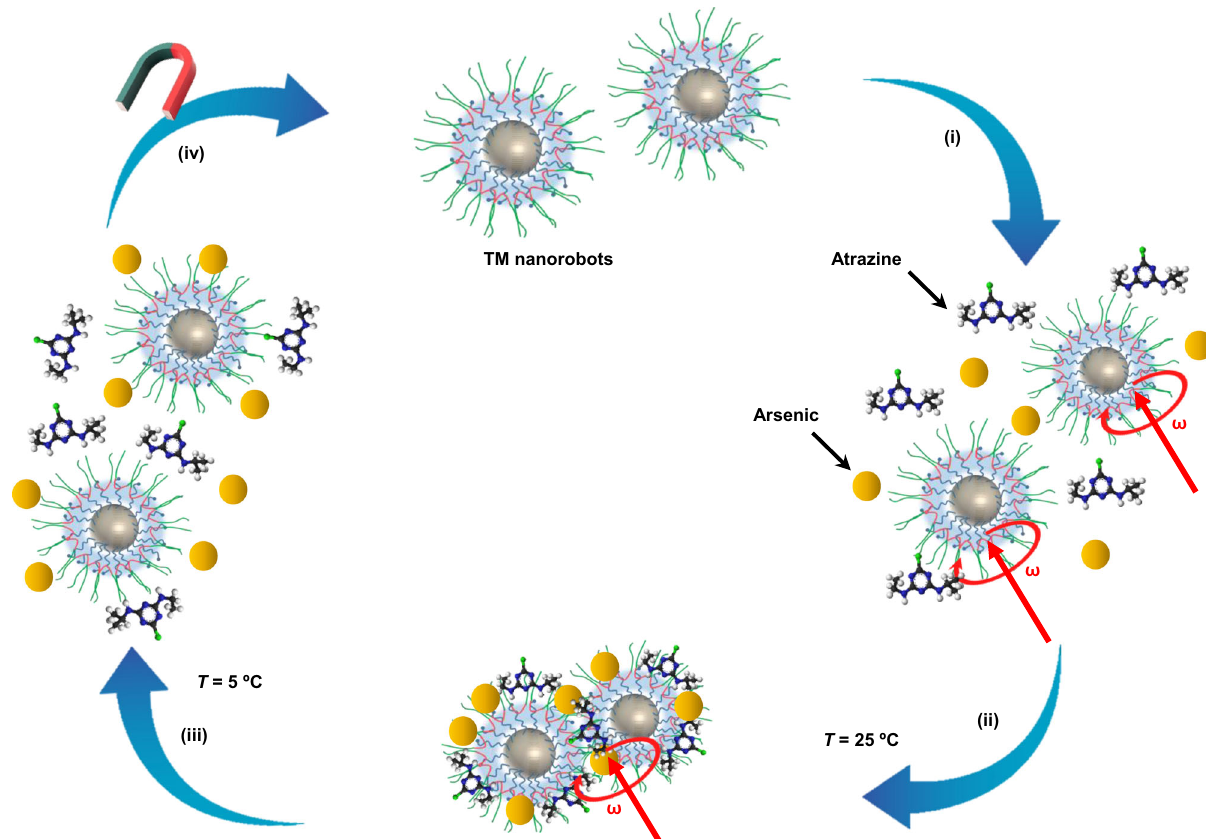
Fig. 1 Formulation of TM nanorobots for water-treatment applications. (i) TM nanorobots walking in polluted water under a transversal rotating magnetic fi eld ( ω ), (ii) pollutants are picked up by the TM nanorobots via intermicellar aggregation at ambient temperature (T) under a transversal rotating magnetic fi eld, (iii) separation of TM nanorobots to dispose of the pollutants from PTBC matrix at low temperature, and (iv) TM nanorobots recovered by using an external